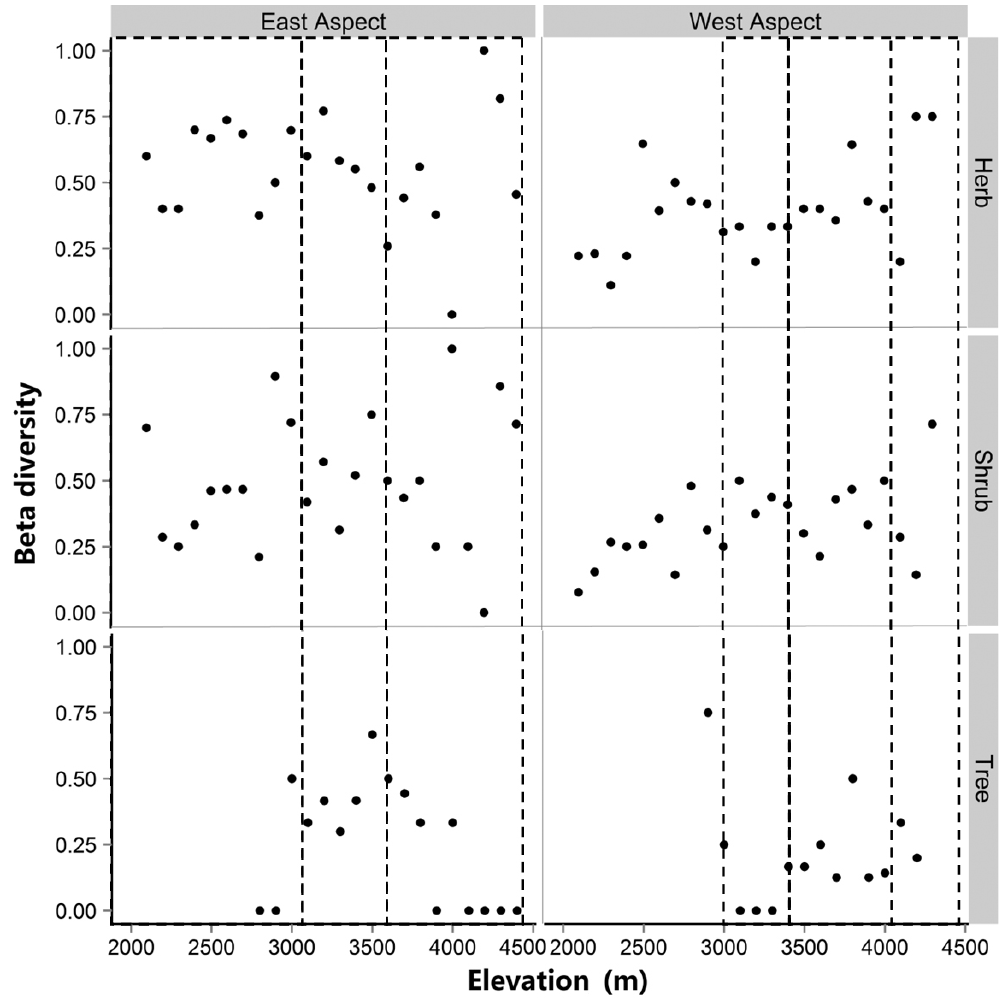
Figure 5. Species turnover rates of all plant species and of trees, shrubs and herbs along an elevation gradient on eastern and western aspects of Baima Snow Mountain.